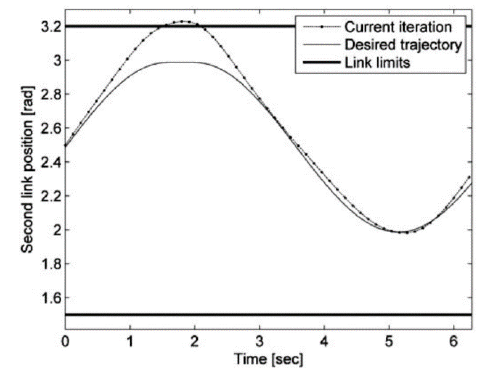
Figure 1a. Violation of generalized coordinates constraints [8]